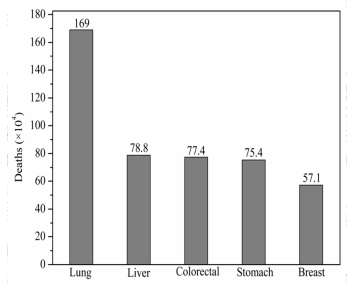
Figure 1. The top five ranking of the most common cancer deaths across the world from the World Health Organization’s report in 2015